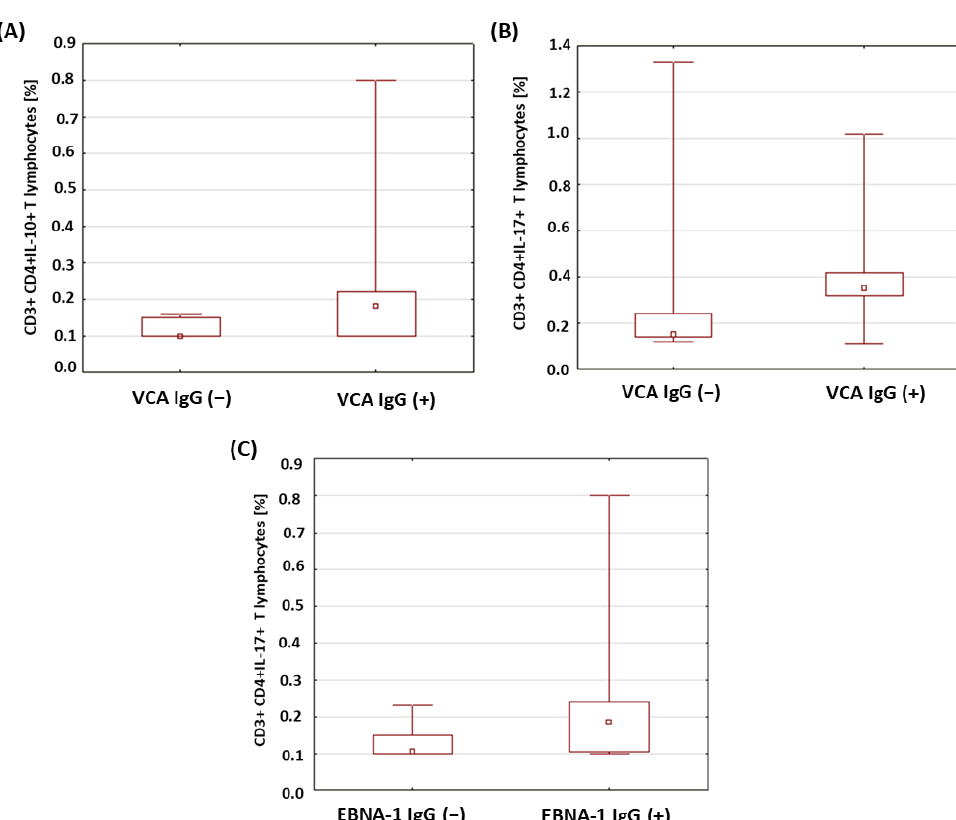
Figure 6. Comparison of the percentages of selected subpopulations of lymphocytes showing intracellular expression of the studied interleukins in patients with type 1 diabetes in relation to the presence of anti-VCA and anti-EBNA-1 antibodies in the IgG class. ( A ) Comparison of the percentage of CD4+CD3+ T cells with intracellular IL-10 expression in type 1 diabetic subjects according to the presence of anti-VCA IgG antibodies; ( B ) comparison of the percentage of CD4+CD3+ T cells with intracellular expression of IL-17 in type 1 diabetic subjects according to the presence of anti-VCA IgG antibodies; ( C ) comparison of the percentage of CD4+CD3+ T cells with intracellular IL-10 expression in type 1 diabetic subjects according to the presence of anti-EBNA-1 IgG antibodies. Table 8. Evaluation of selected parameters of carbohydrate balance in patients with type 1 diabetes in relation to the presence of anti-VCA antibodies in the IgM, IgG and anti-EBNA-1 in the IgG